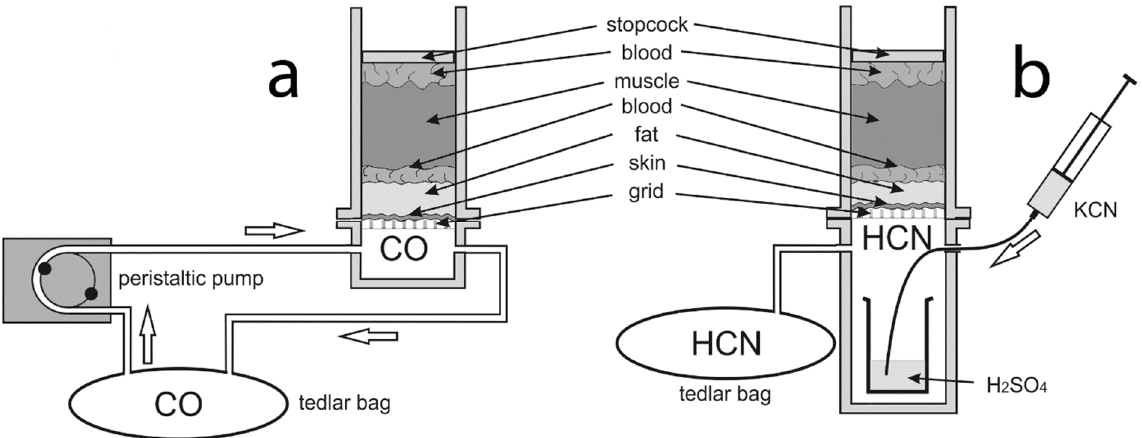
Figure 2. A diagram of CO ( a ) and HCN ( b ) experiments.